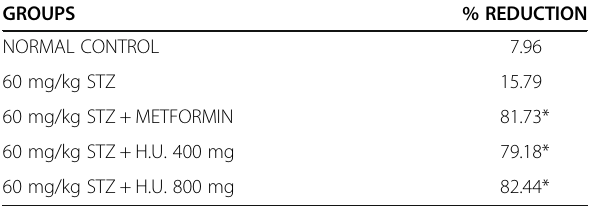
Table 4 Percentage reduction in fasting blood glucose levels GROUPS